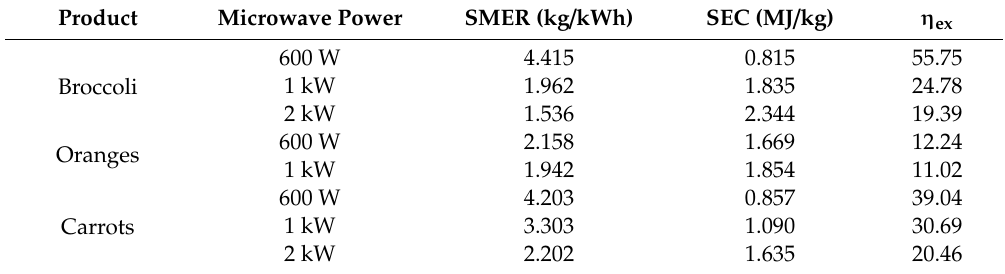
Table 2. Specific moisture extraction rate (SMER), specific energy consumption (SEC), and η ex values for the REV-dried broccoli, oranges, and carrots.